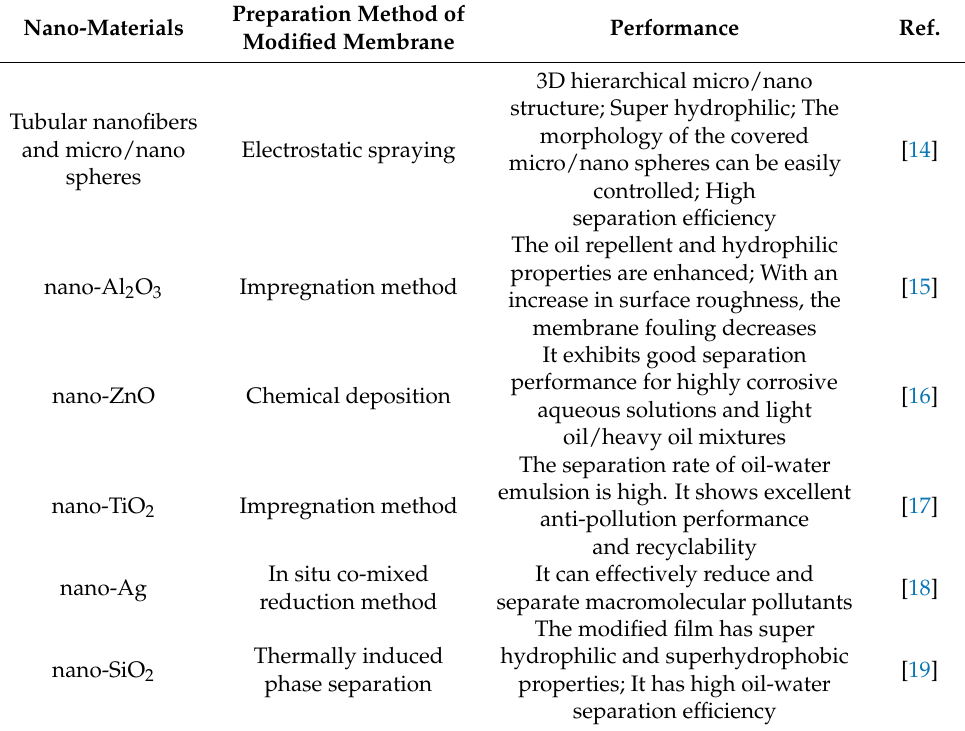
Table 2. Nano-material modified